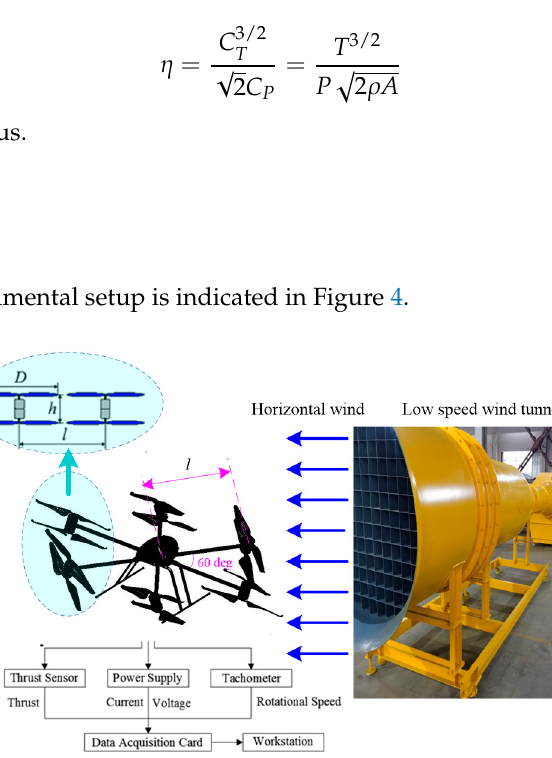
Figure 4. Sketch of experimental setup.